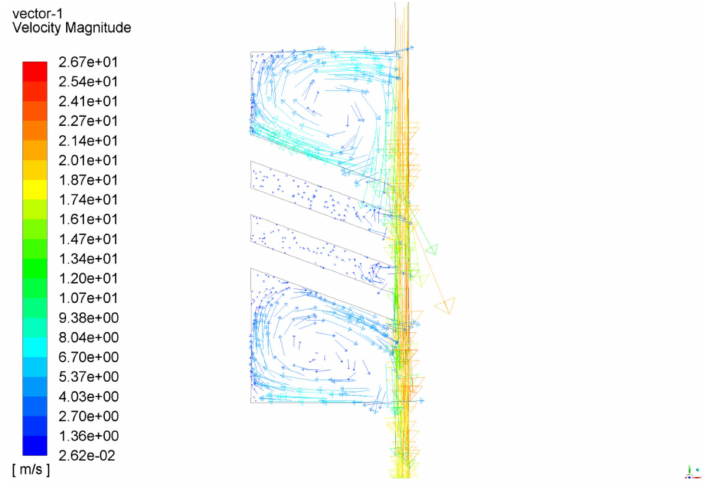
Figure 8. Velocity